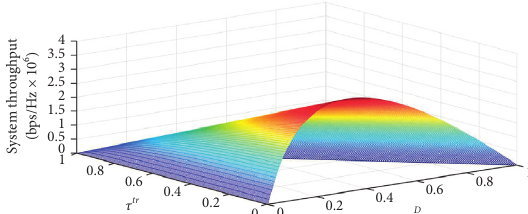
Figure 3: The relationship between system throughput and the time allocation scheme when τ U � 1 − τ D − τ tr with N � 2, L � 8, P � 1mW, σ 2 � − 50dBm/Hz, and η � 0 . A